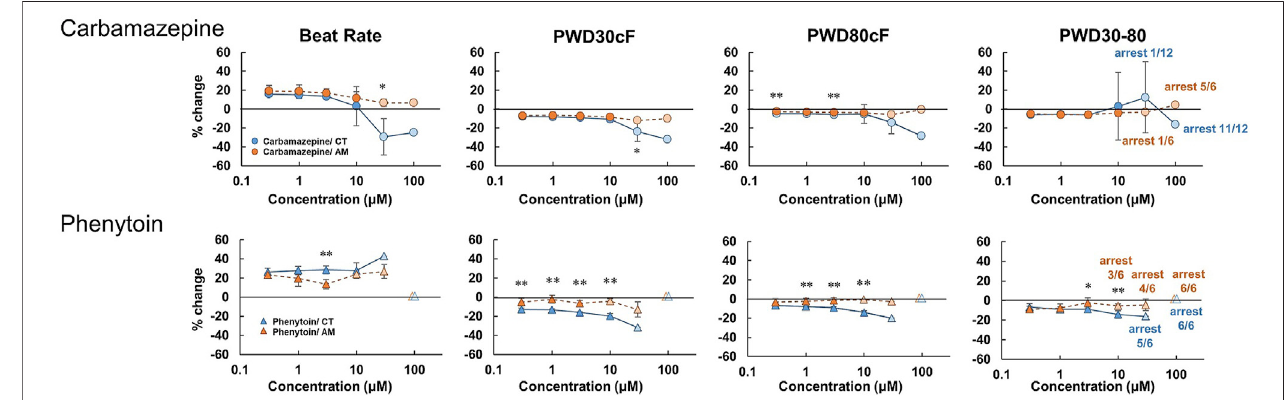
FIGURE6| Dose-responseofsodium ionchannelregulatorinCTandAM.ComparisonofMPparameters:beatrate,PWD30cF,PWD80cF,PWD30-80inCTand AM after application ofcarbamazepine and phenytoin. Error bars represent SD of the mean from the values of independent experiments. n (cid:2) 6 – 12. * p < 0.05, ** p < 0.01 for comparison of drug treatment of CT vs.